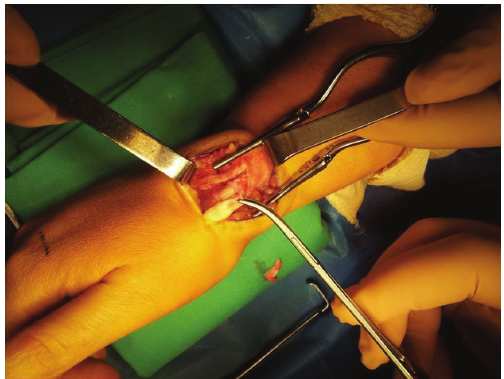
Figure3:Intraoperativeviewshowingatotalruptureoftheextensor pollicis longus tendon with a 10% diameter reduction of the extensor carpi radialis longus tendon without